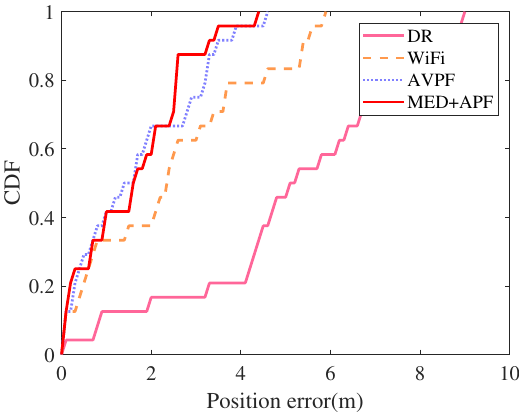
Figure 14. CDF of errors.